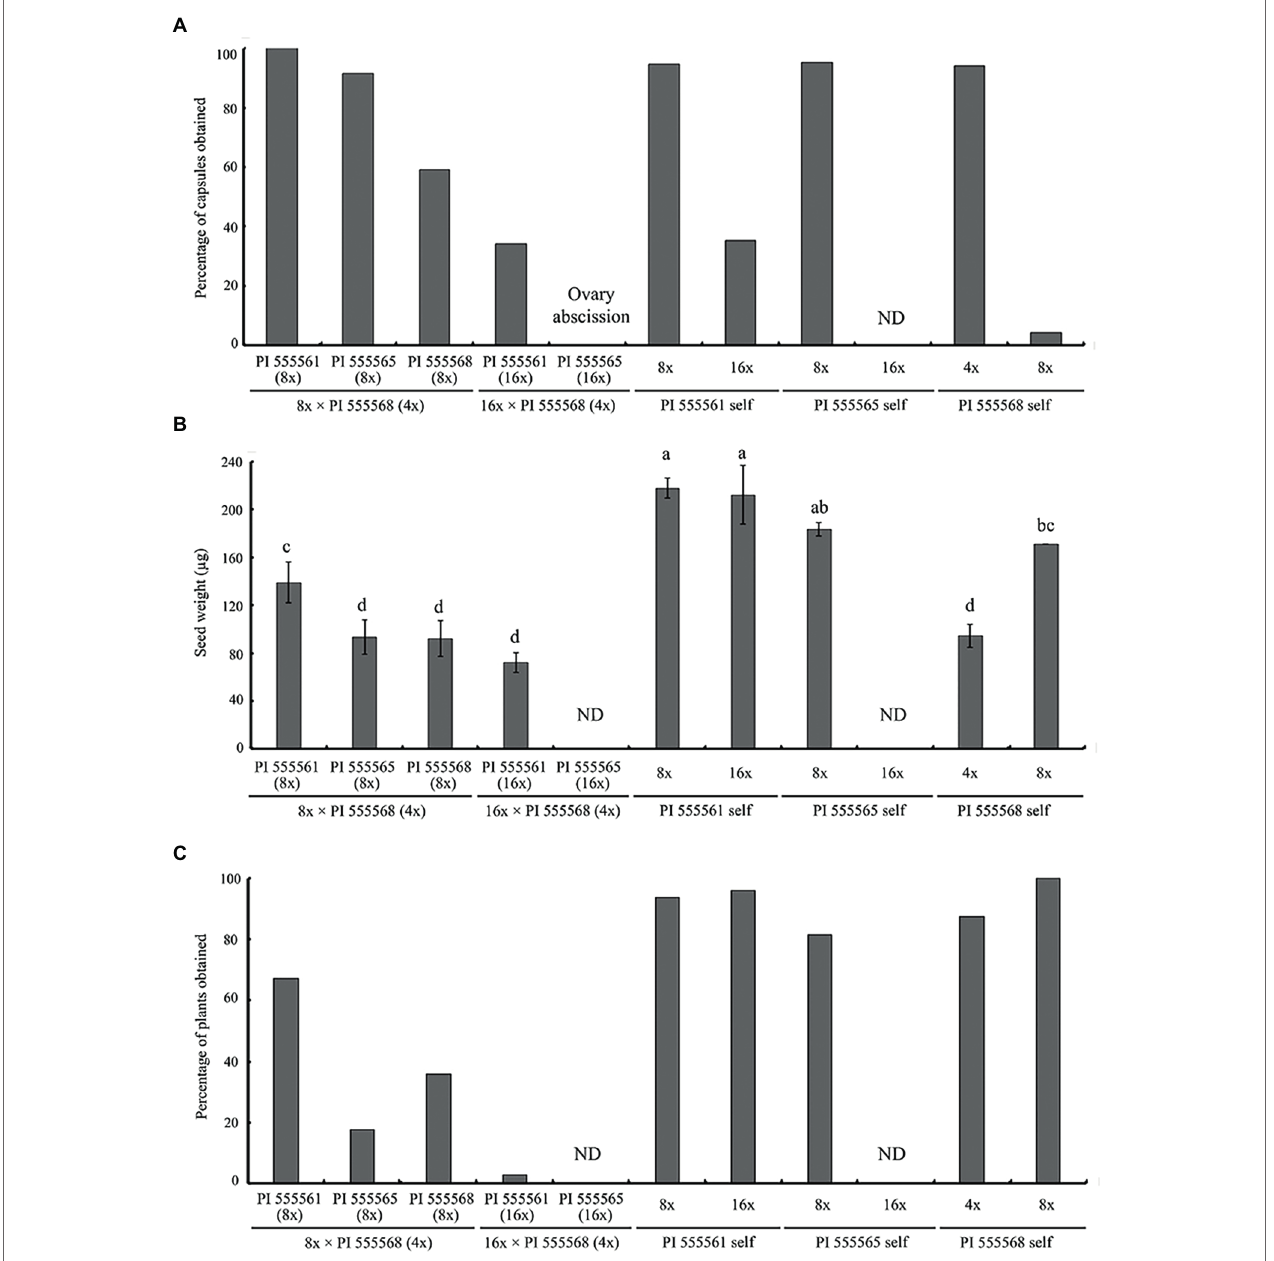
FIGURE 4 | Ovary abscission and seed abortion were observed in intraspecific-interploidy crosses of Nicotiana suaveolens . (A) Percentages of capsules produced after pollination. (B) Single seed weight. Bars represent standard error. Different lowercase letters indicate significant differences at the 5% level as per Tukey’s test. (C) Percentages of plants obtained after seed sowing. ND, no data. The data for self-pollinations other than PI 555565 (16x) have been reported previous (He et al., 2020) and are included here for